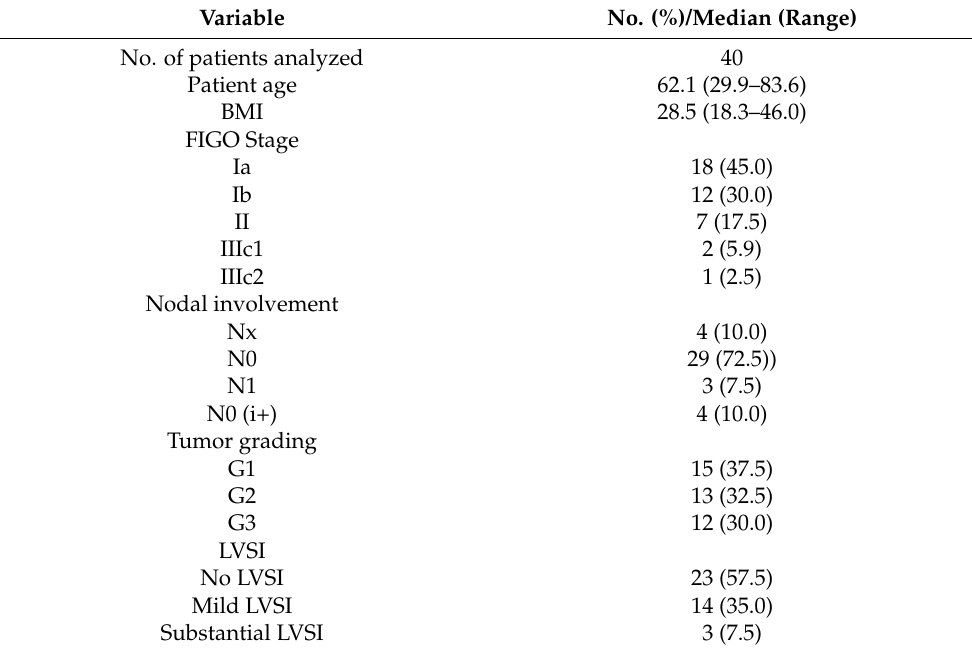
Table 2. Patient demographics.